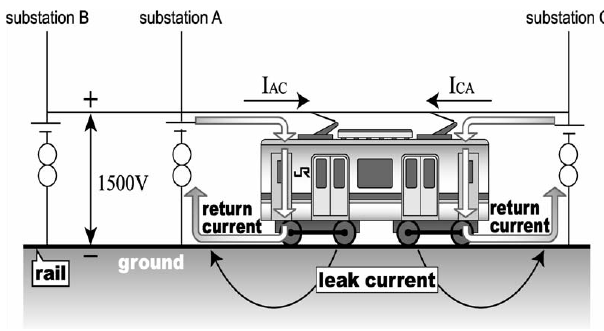
Fig. 5. Schematic view of the electric circuit for a DC-driven train system.